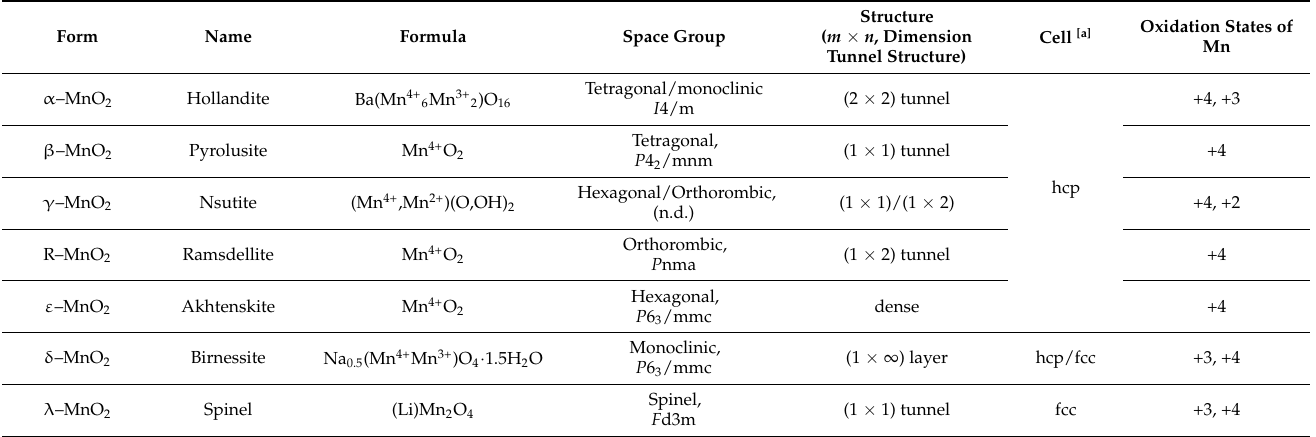
Table 1. Main MnO 2 forms and their basic structural characteristics. Adapted from References